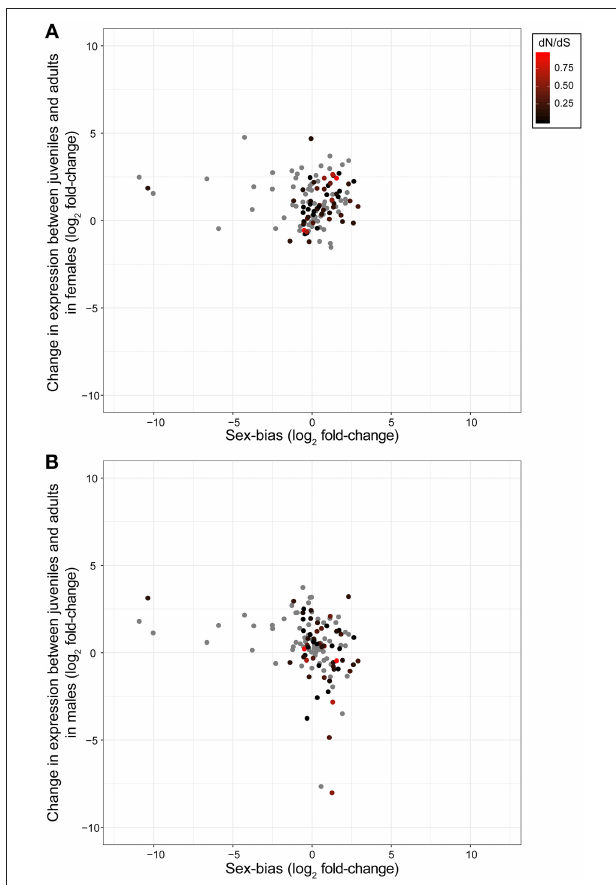
FIGURE 3 | Expression changes of olfactory genes between T. cristinae developmental stages in females (A) and males (B) , and between adult males and females. Olfactory genes involved in sexual communication are expected to mostly be expressed in adults and feature sex-biased expression. They are further expected to be under relaxed selection in asexual species (red points, see legend) where sexual communication no longer occurs. (No dN/dS rates could be determined for the gray points because of lack of polymorphism or orthology). None of the candidate olfactory genes identified in T. cristinae clearly fit with these expectations. Positive values for sex-bias indicate higher expression in females, and positive values for expression between developmental stages indicate higher expression in